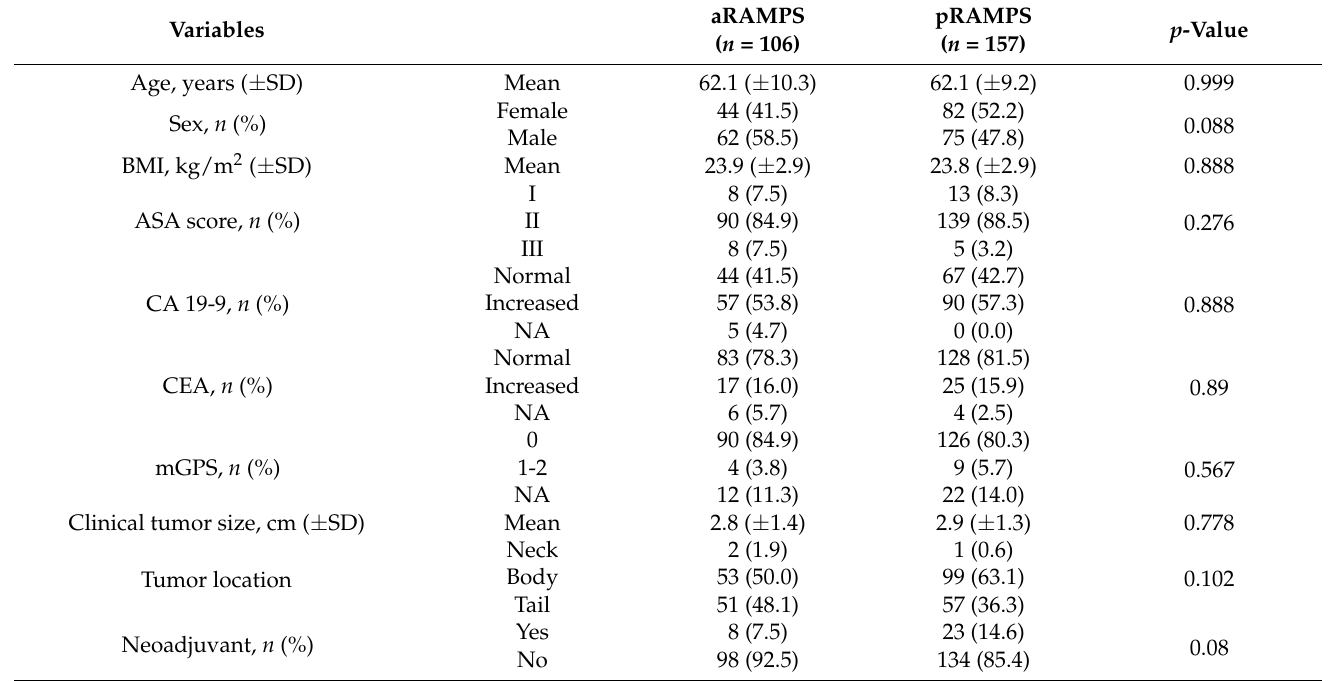
Table 4. Demographic and clinical characteristics of patients who underwent radical antegrade modular pancreatosplenec- tomy without periadrenal infiltration.